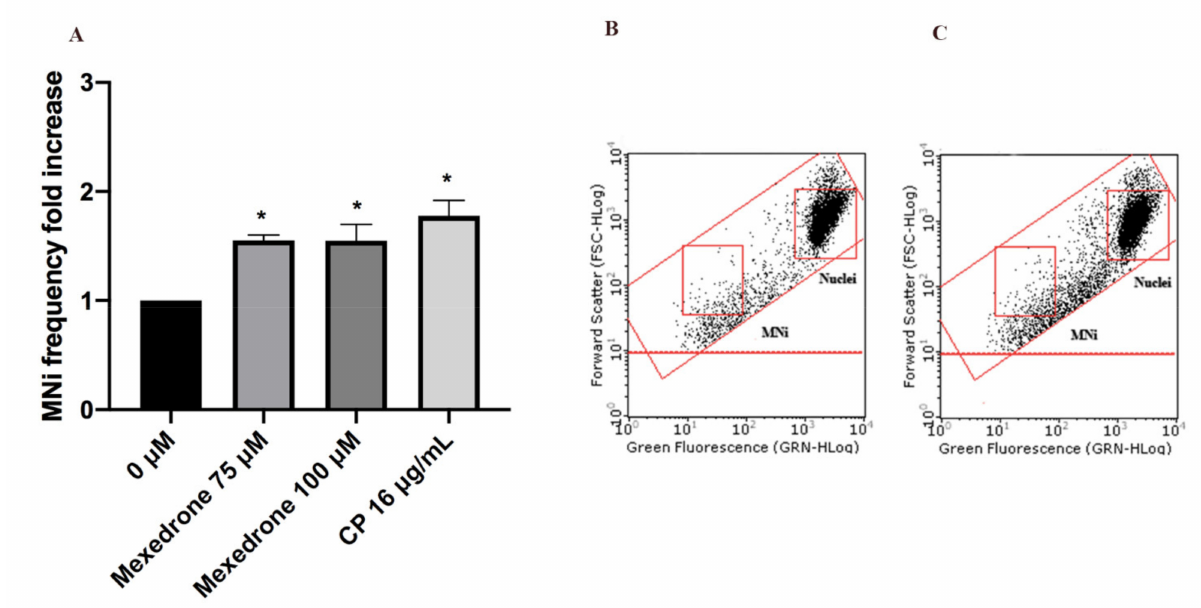
Figure 6. MNi frequency fold increase on TK6 cells after 3 h + S9 mix treatment with mexedrone at the indicated concentrations compared to the negative control [0 µ M] and to the positive control [CP] ( A ), plot of nuclei and MNi in the negative control ( B ) and in 100 µ M mexedrone-treated cultures ( C ). Each bar represents the mean ± SEM of five independent